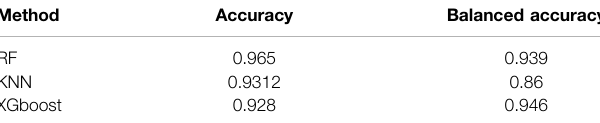
TABLE 3 | Test accuracy before clustering (test